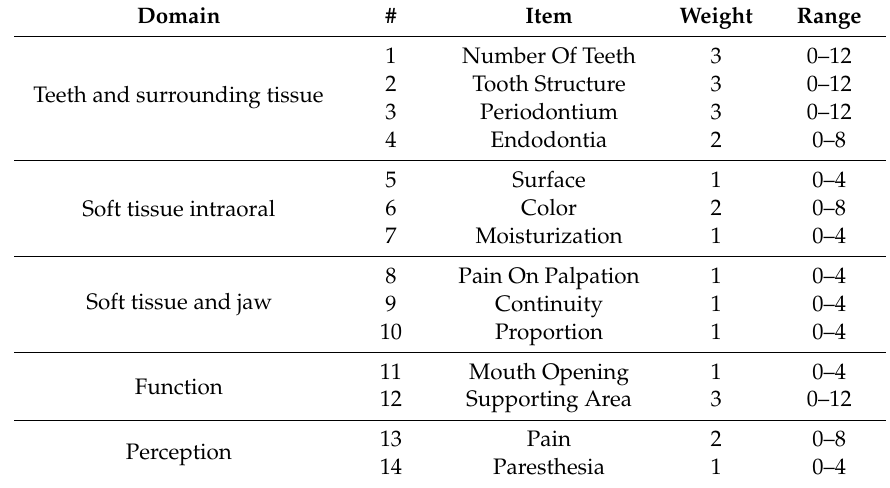
Table 1. Physical Oral Health Index (PhOX) domains and weights with the range for the values of each item. Translated domains and items from the Physical Oral Health